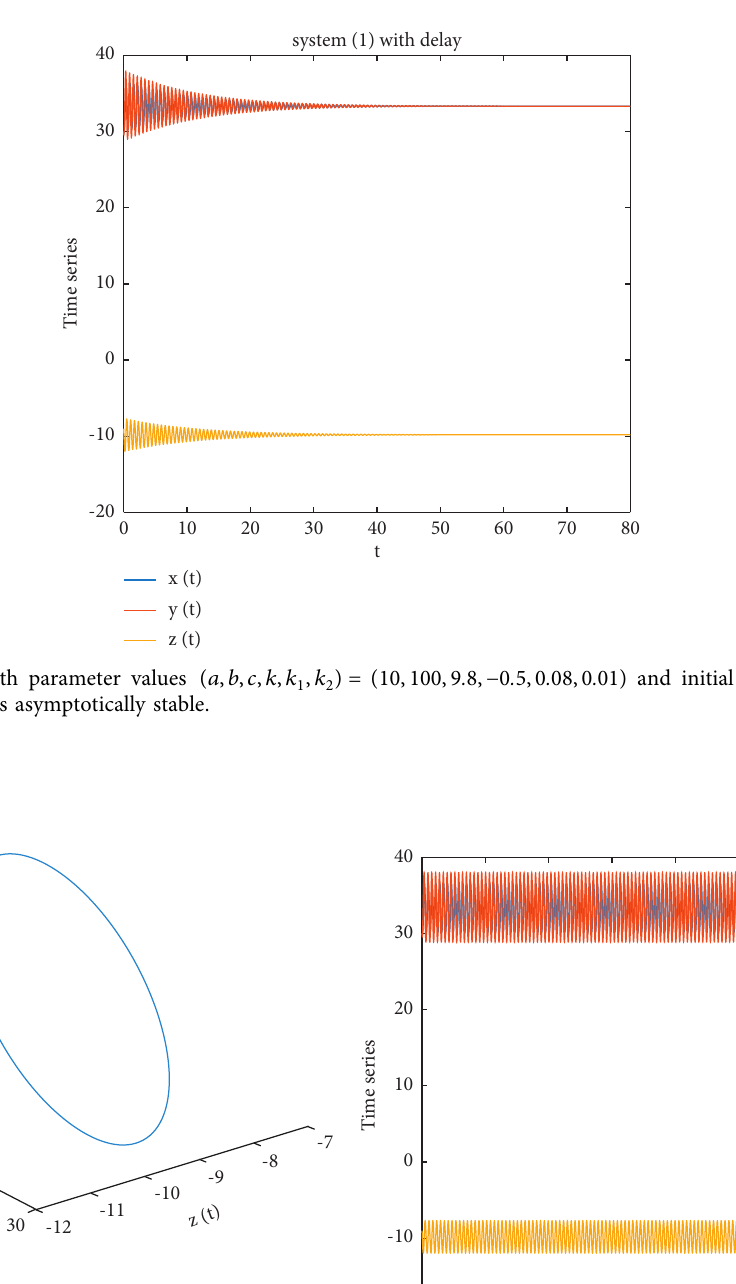
, k ) � ( 10 , 100 , 9 . 8 , − 0 . 5 , 0 . 08 , 0 . 01 ) and initial values 1 2